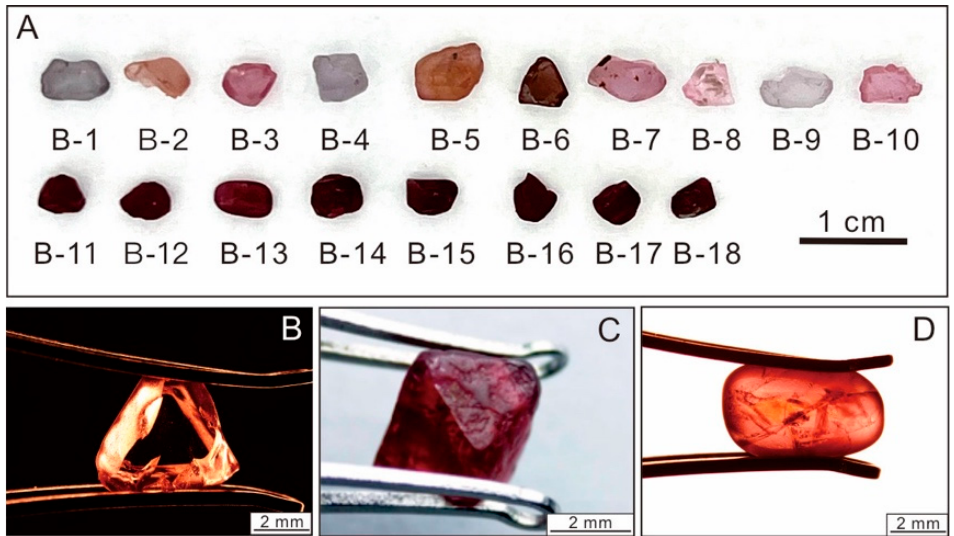
Figure 3. ( A ) The 18 Mogok spinel rough samples collected and examined for this study; ( B ) twin crystal of B-6 orange spinel sample under 40× dark field; ( C ) octahedral crystal of B-14 red spinel sample under 50× reflected; ( D ) water-eroded-pebble shaped crystal of B-13 red spinel sample under 40× incident. The B-1, B-4 and B-9 are purple samples; B-2, B-5, B-6 are orange samples, B-3, B-7, B-8 and B-10 are pink samples, and rest of them are red (B-11 to B-18).